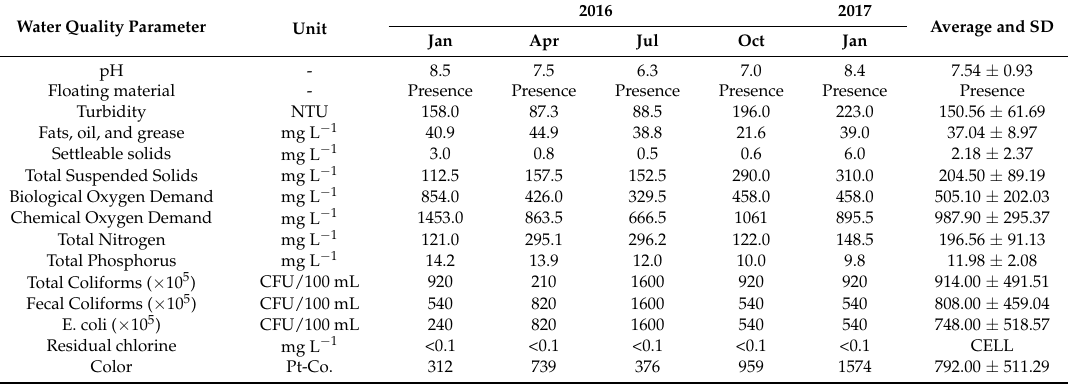
Table 2. Water quality parameters at the entrance of the septic tank (ST) (SD = standard deviation).